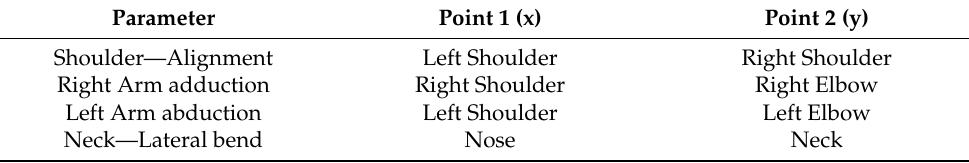
Table 3. Points used to evaluate each